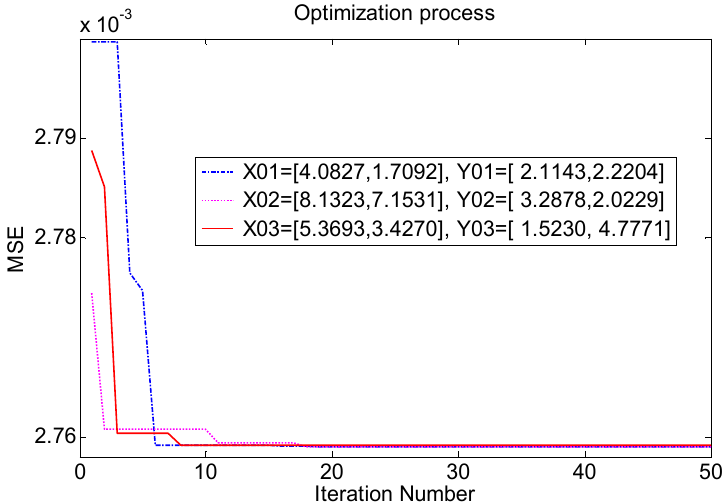
Figure 6. Convergence histories of different initial positions.